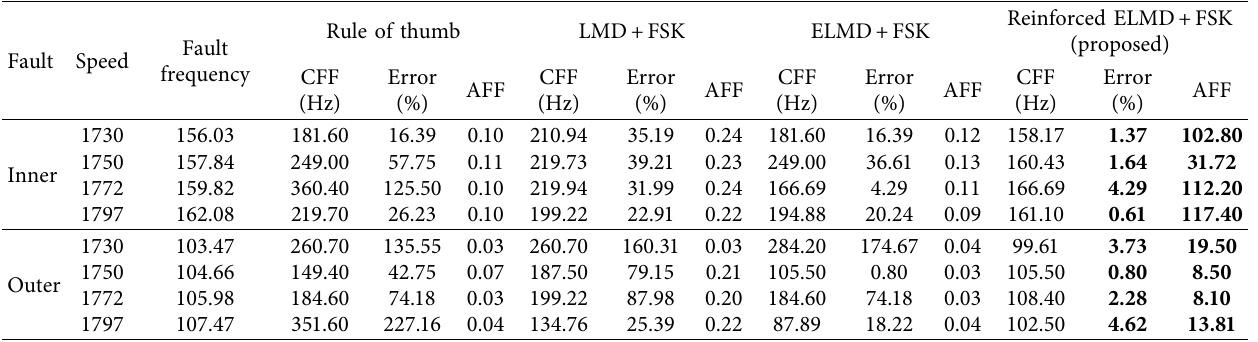
Table 4: Performance comparisons under strong background noise by decreasing SNR to 1/6 of the original data from CWRU dataset. Fault Speed